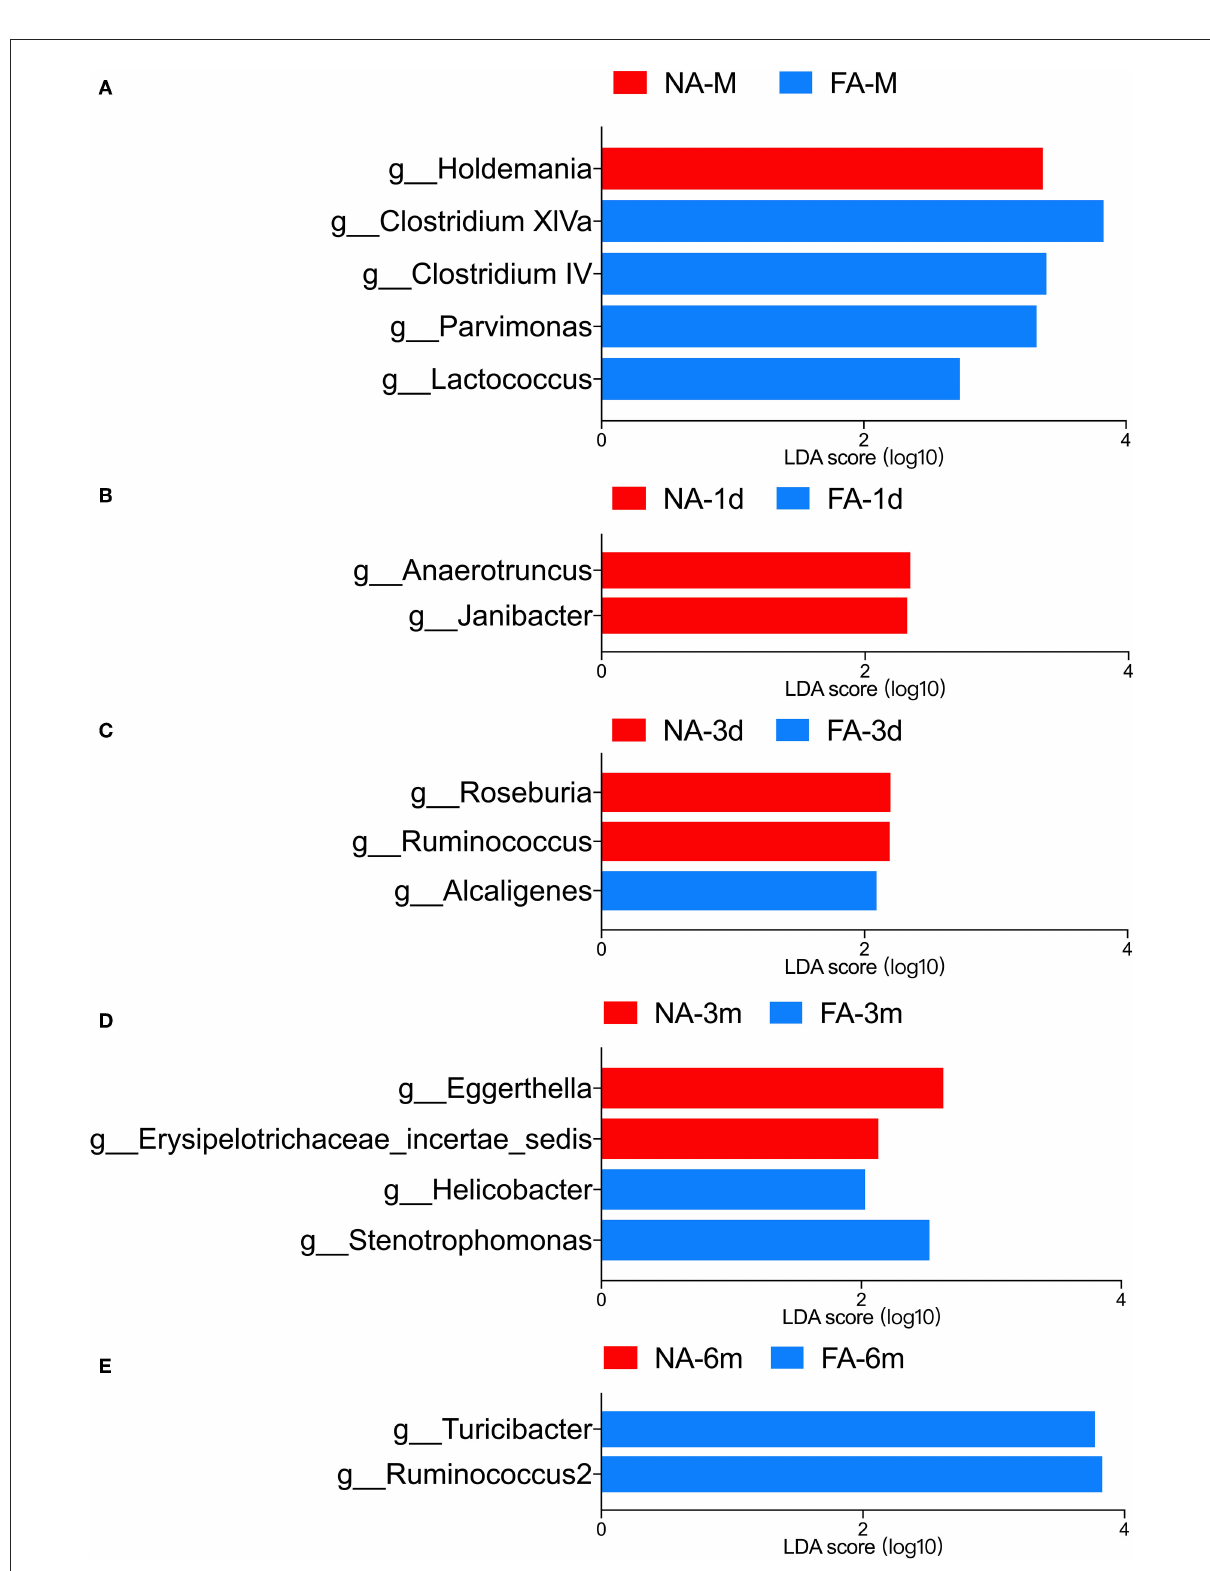
FIGURE9 LEfSe analysis of maternal (A) and infant gut microbiota at different timepoints (B–E) was compared between the non-allergy group (NA) and food allergy (FA) groups. Only the genera with linear discriminant analysis (LDA) scores > 2 and P < 0.05 are